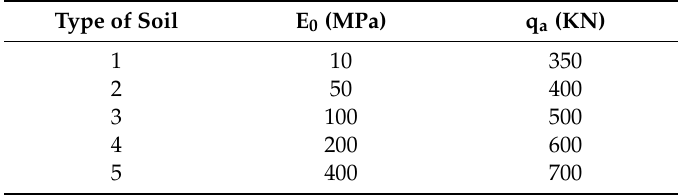
Table A1. Adjustment parameters of the soil considered (initial Young module and